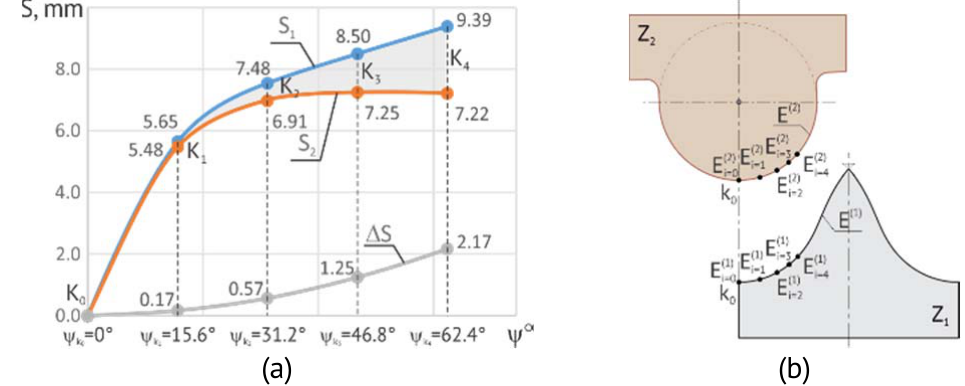
and E between positions 1 2